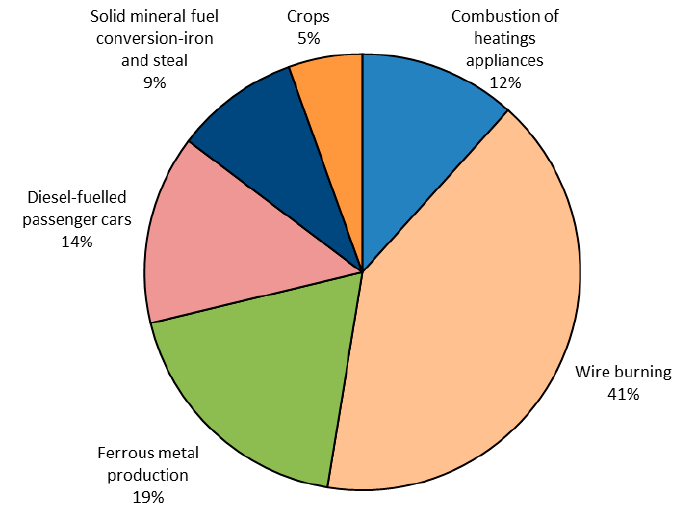
Figure 3. Summary of relative emissions from various industry sectors in 2015.